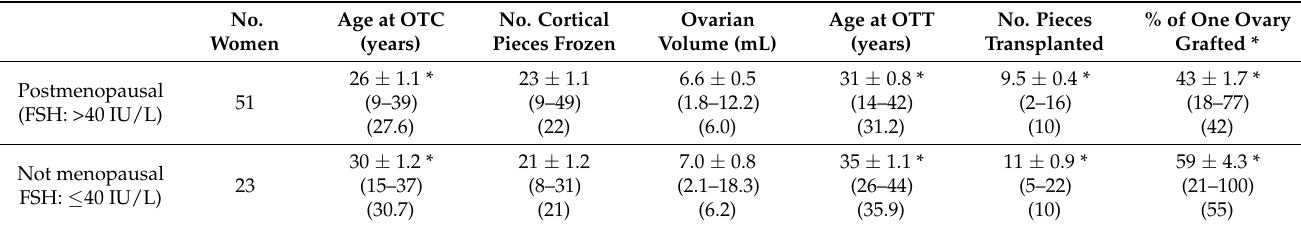
Table 1. Characteristics of women transplanted with ovarian tissue in relation to whether or not they had postmenopausal levels of FSH (>40 IU/L) at the time of transplantation.